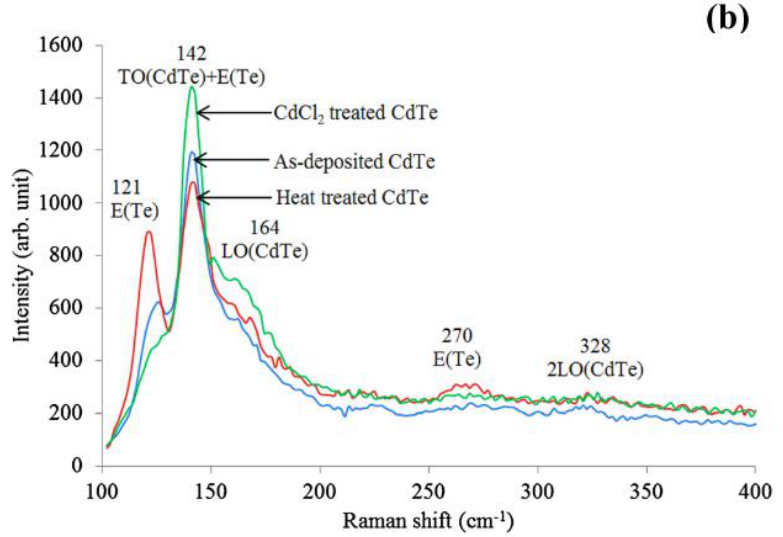
Figure 3. ( a ) XRD and ( b ) Raman spectra recorded for as-deposited (green), heat-treated in air (red) and CdCl 2- treated (violet) CdTe layers to demonstrate the removal of excess Te during CdCl 2 treat- ment [19]. CdCl 2 treatment [19].